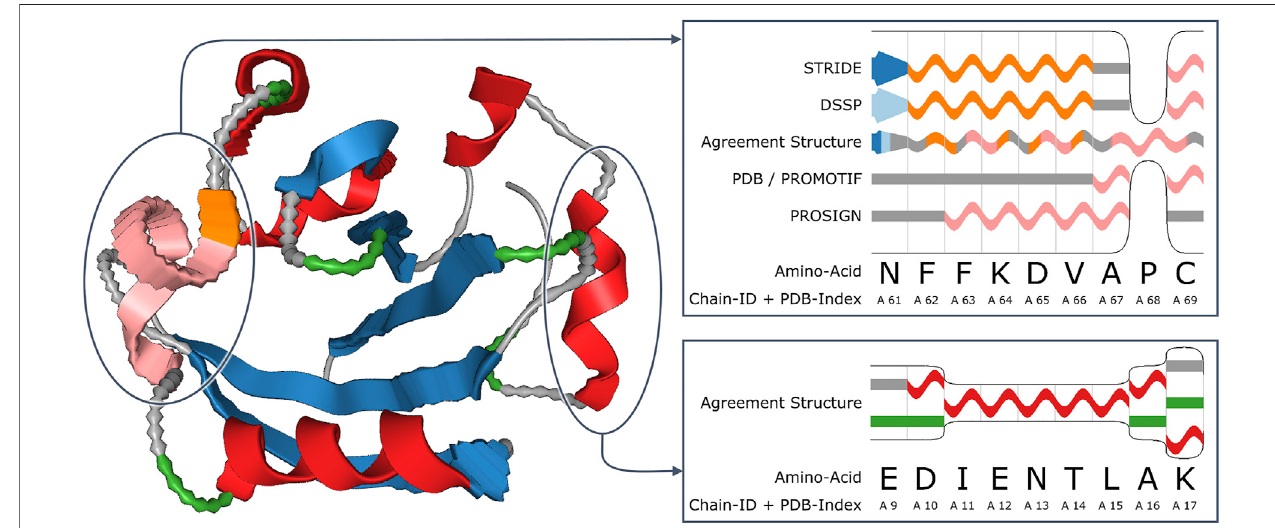
FIGURE 6 | Visualization of uncertainty in secondary structure assignment for the example of the photoactive yellow protein of E. coli (PDB ID: 2ZOI). The ribbon diagram (left image)representsthisuncertaintyinthe formofwavinessinthe geometric shape. The insets show details ofparts ofthesequence diagrams (imagestothe right),stackingthedifferingassignmentsalongtheverticalaxis.Theagreementstructuremergestheassignmentresultswherepossible.Image: © 2018IEEE.Reprinted, with permission, from Schulz et al.